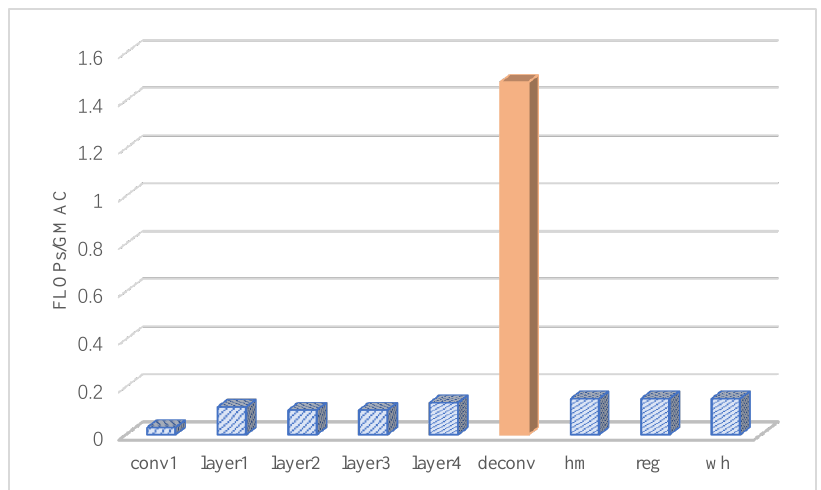
Figure 2. Calculations of different layers of CenterNet-resnet18.